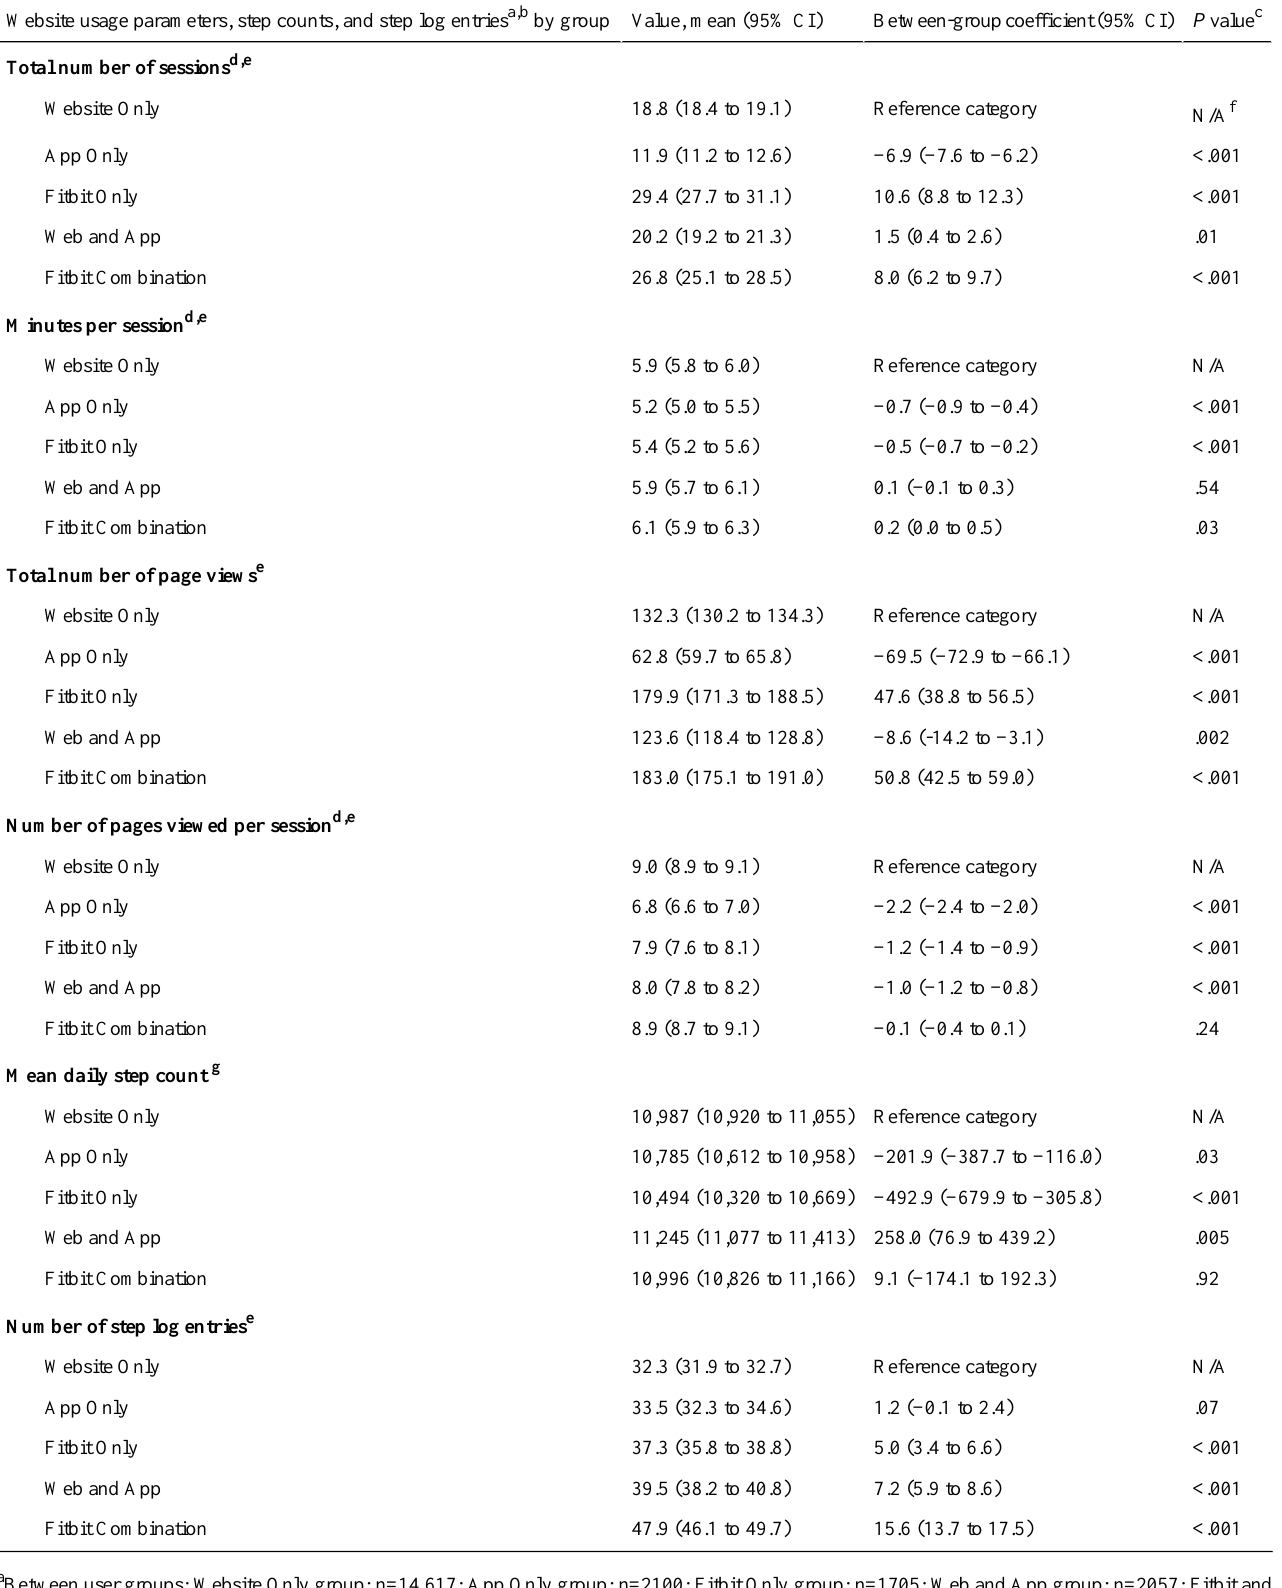
Table 2. Marginalized means and between–user group differences for website usage and mean daily step count and logging between January 1 and December 31,